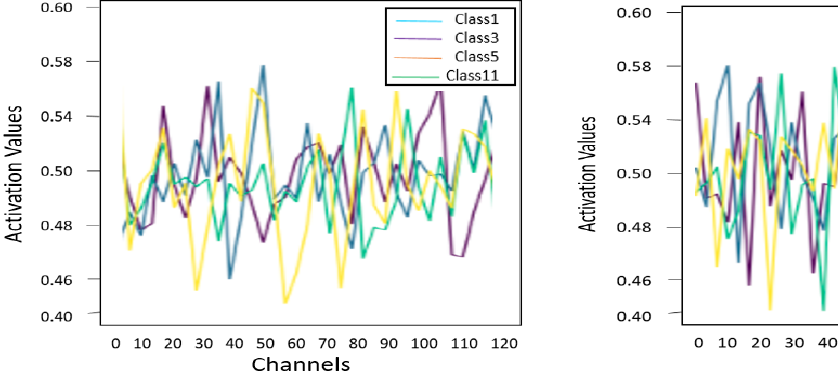
( b ) Figure 13. With and without spatial–spectral SE blocks vs. overall accuracy (OA%): ( a ) 5% training samples; ( b ) 10% training samples. 4.2. Exploring Spatial–Spectral Effects on Class Samples Furthermore, the usefulness of the spatial–spectral SE block in the proposed model, SE-AB-DenseNet with cutout, was observed to determine how the model improved its performance. Moreover, it is important to identify the practical instinctive mechanism of the SE-AB-DenseNet with the cutout model. Hence, in this section, classification features of discrete samples’ behaviors are observed in the proposed model, and different classes of different SE blocks are also studied. For experiments, the Indian Pines dataset is con- sidered as it focuses on strong vegetation classes; however, among them, randomly, there